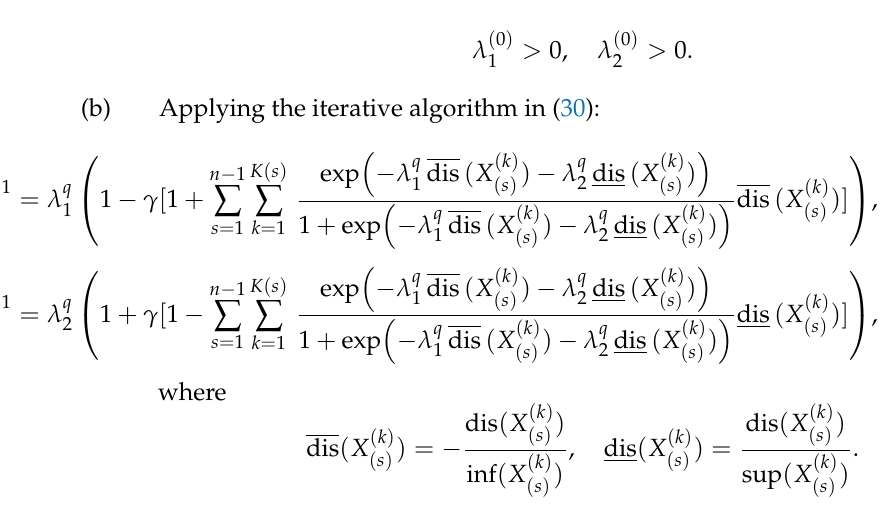
Determining the Lagrange multipliers λ 1 and λ 2 for the finite-dimensional